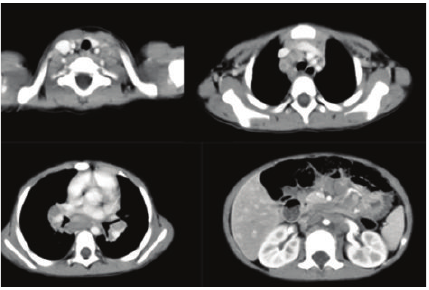
Figure 2: Thoracic and abdominal CT shows multiple lymph node enlargements in the regions of the bilateral neck and hilum, as well as the mediastinum and retroperitoneal